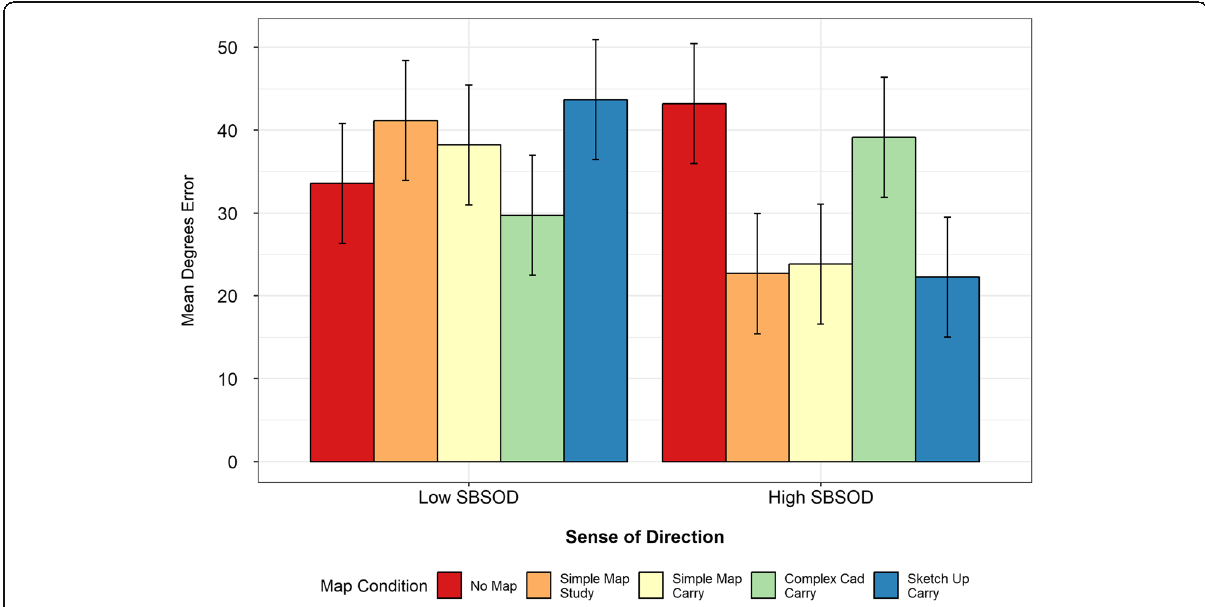
Fig. 8 Mean pointing error across map conditions by median split of Mean Santa Barbara Sense of Direction (SBSOD). Error bars in this and all subsequent figures are 95% confidence